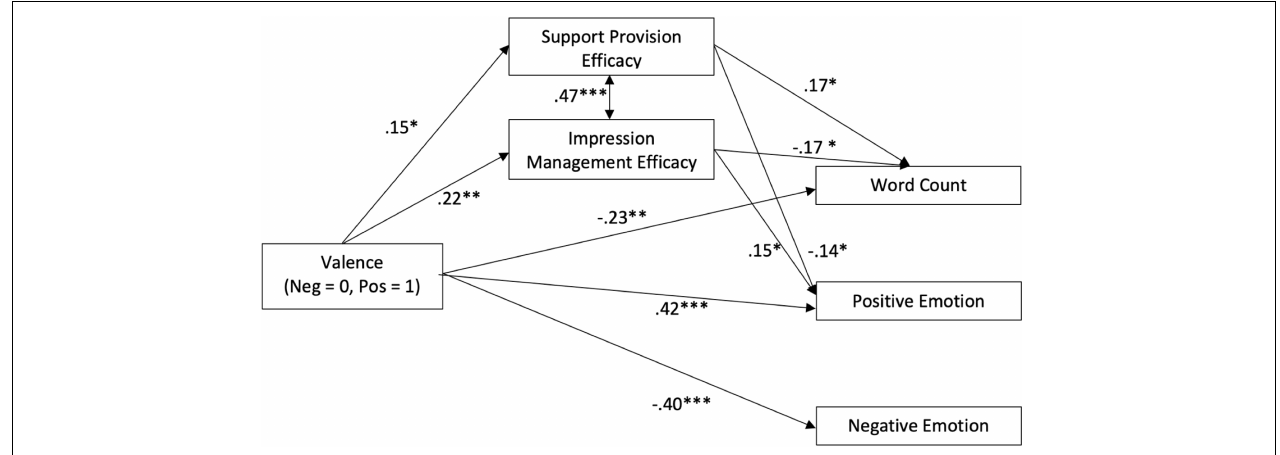
FIGURE 2 | The path model of message valence, efficacy perceptions and linguistic features of responses. * p < 0.05. ** p < 0.01. *** p <